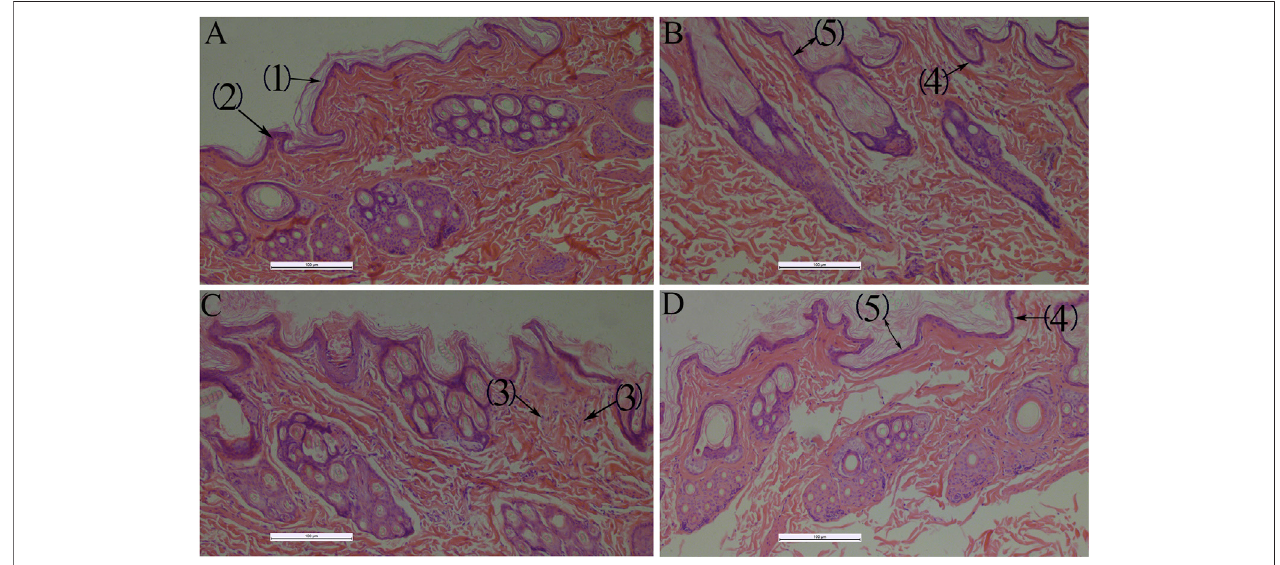
FIGURE13| Histologicalphotomicrographsofafrozensectiontakenfromrabbittreatedwithseveralapplications100 × , (A) :Normalskin-control (B) :Normalskin- drug, (C) : Damaged skin-control, (D) : Damaged skin-drug; (1): Stratum corneum, (2): Stratum spinosum, (3): In fl ammatory cells, (4): Stratum basale, (5):